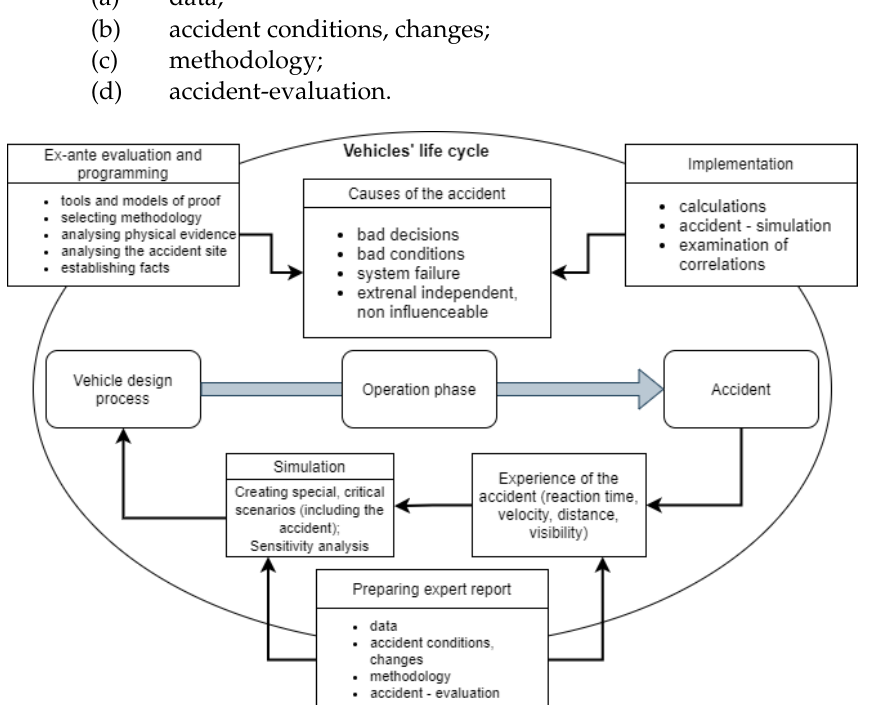
Figure 1. New accident analysis